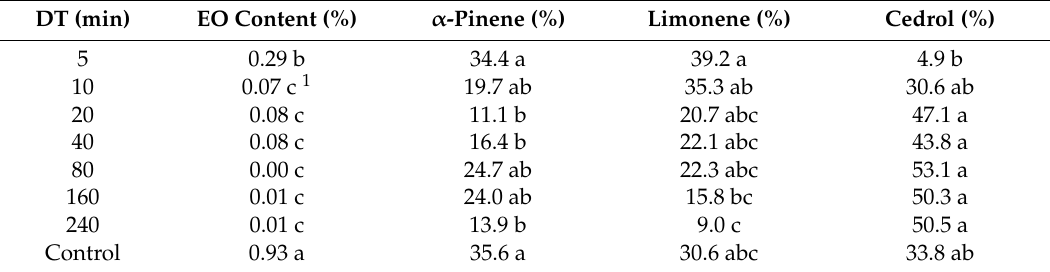
Table 4. Mean Juniperus excelsa essential oil (EO) content (%), and the concentrations (%) of α -pinene, limonene, and cedrol in the EO fractions that were obtained from the eight distillation timeframes (DT). DT (min) EO Content (%) α -Pinene (%) Limonene (%) Cedrol (%) 0.29 b